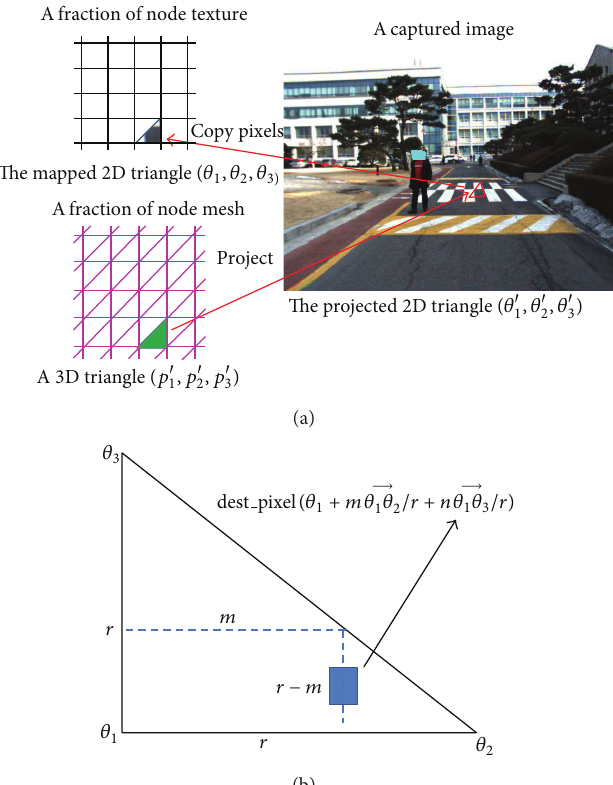
Figure 6: Node texture generation method. (a) Projection from the triangles of a node mesh onto a captured image. (b) Texture triangle duplication.